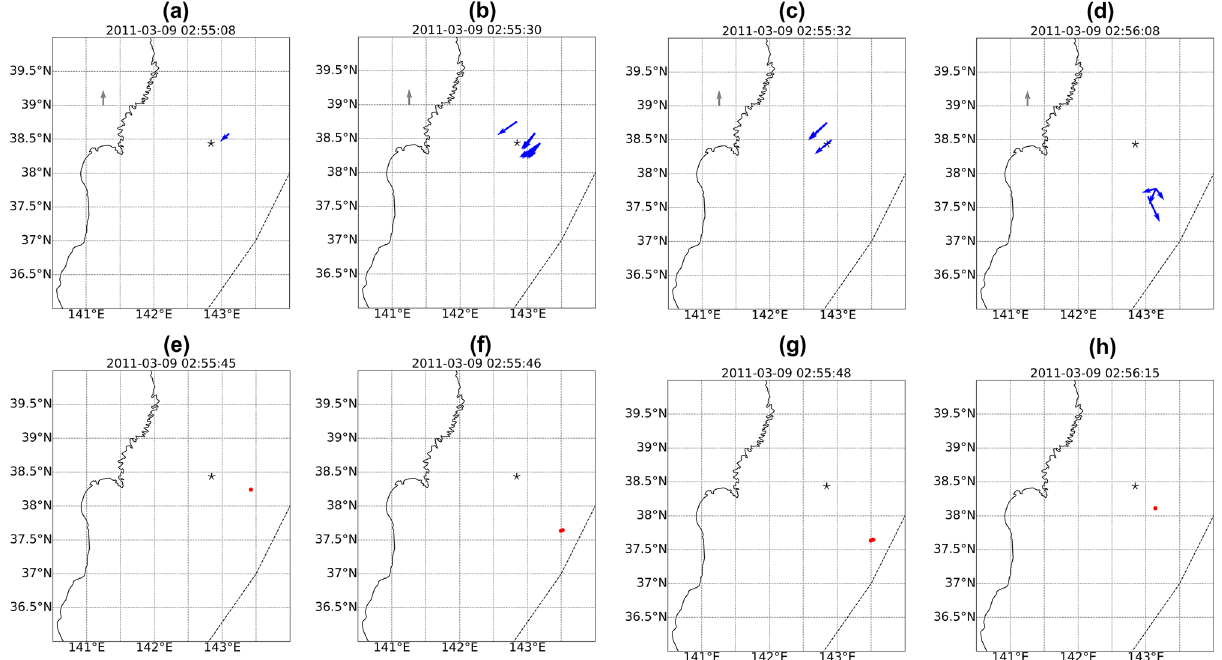
Figure 8. ( a – d ) CTID velocity field calculated from the first CTID detected by GPS satellite PRN 07 following the Sanriku earthquake. The dotted curve shows the position of the Japan Trench, black star depicts the epicenter. The gray arrow corresponds to 1.1 km/s; ( e – h ) localization of the seismic source as estimated from the first velocity vectors shown on panels ( a – d